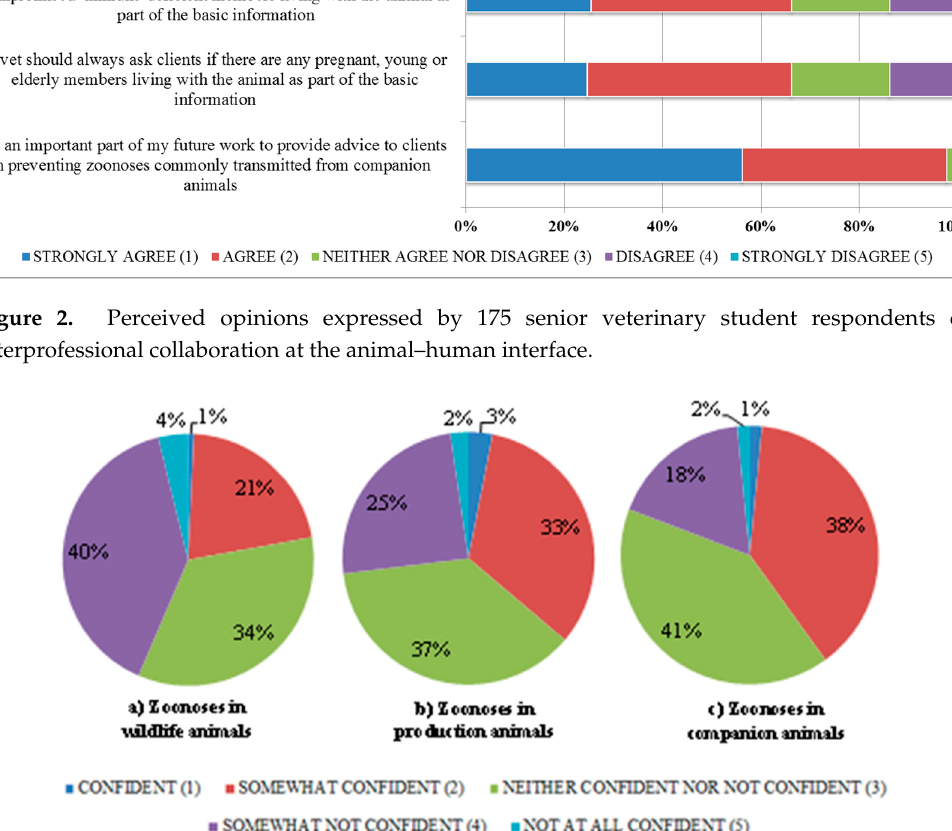
Figure 2. Perceived opinions expressed by 175 senior veterinary student respondents on interprofessional collaboration at the animal–human interface.